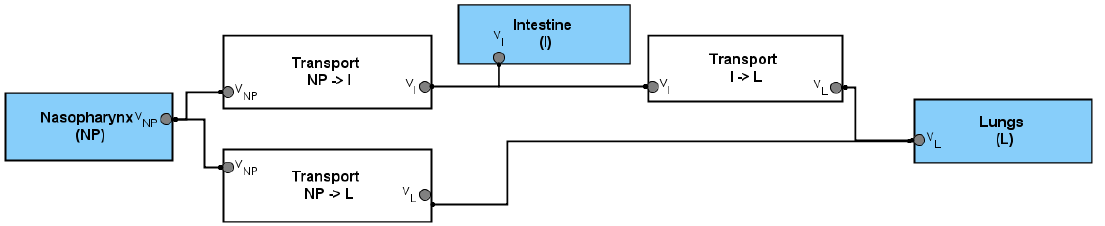
Figure 1. The developed multicompartmental model of the SARS-CoV-2 infection processes and distribution among three human organs, taking into account the virus reproduction in each compartment and viral transport between them. Gray circles are contact ports representing the interface of the module through which it can be connected with other modules or with the integrated model itself. V NP , V I , and V L correspond to viral particles in the nasopharynx, intestine, and lungs, respectively.